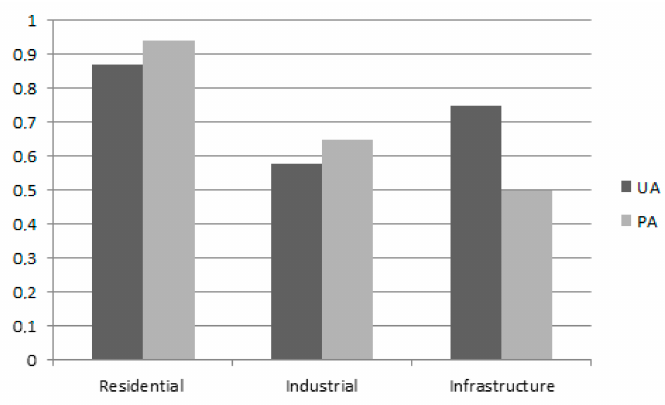
Figure 11. User’s and producer’s accuracy for the determined Change Detection Service Land Use classes.